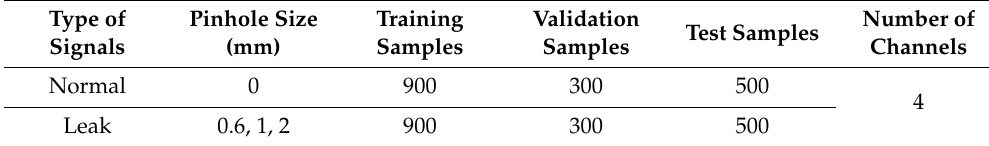
Table 1. Dataset description.